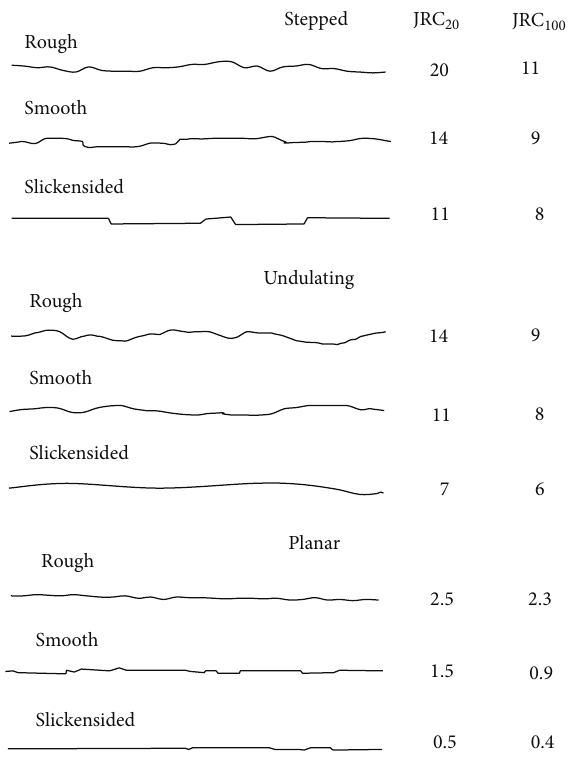
Figure 1: Typical roughness profiles and corresponding range of JRC [7].